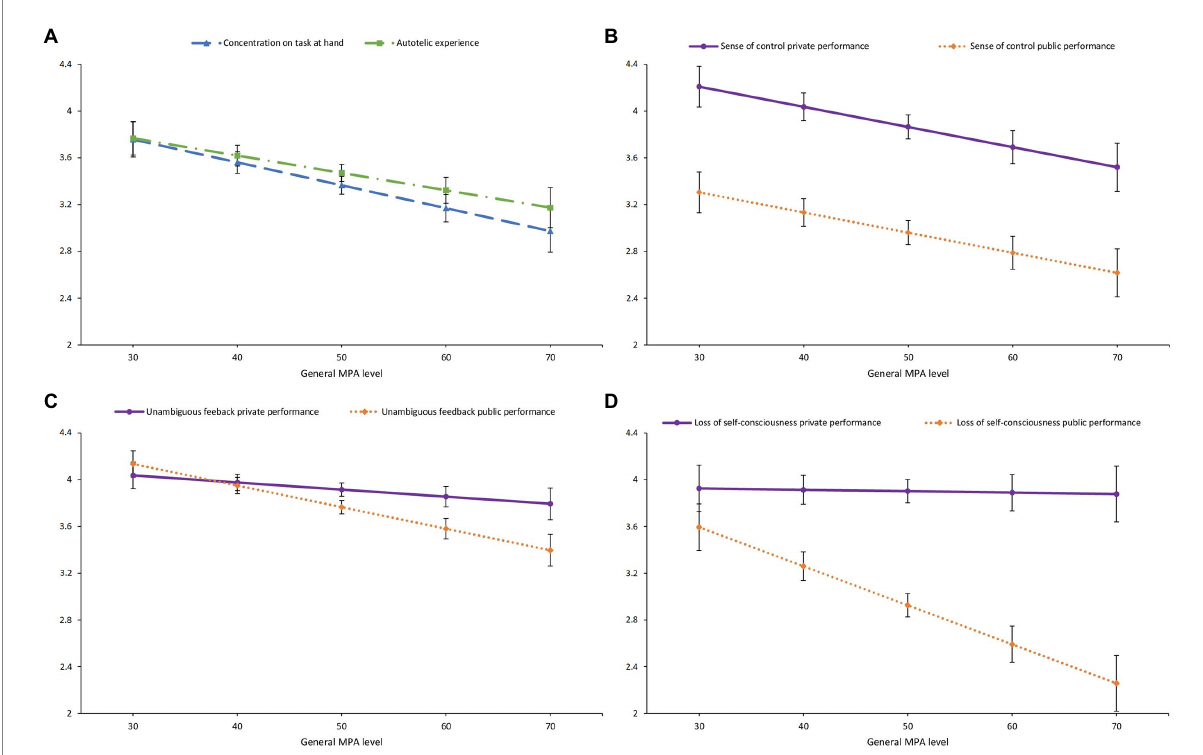
FIGURE 1 Model-predicted marginal means along the general MPA level for (A) “Concentration on task at hand” and “Autotelic experience,” (B) “Sense of control” for the private and for the public performance sessions, (C) “Unambiguous feedback” for the private and for the public performance sessions, (D) “Loss of self-consciousness” for the private and for the public performance